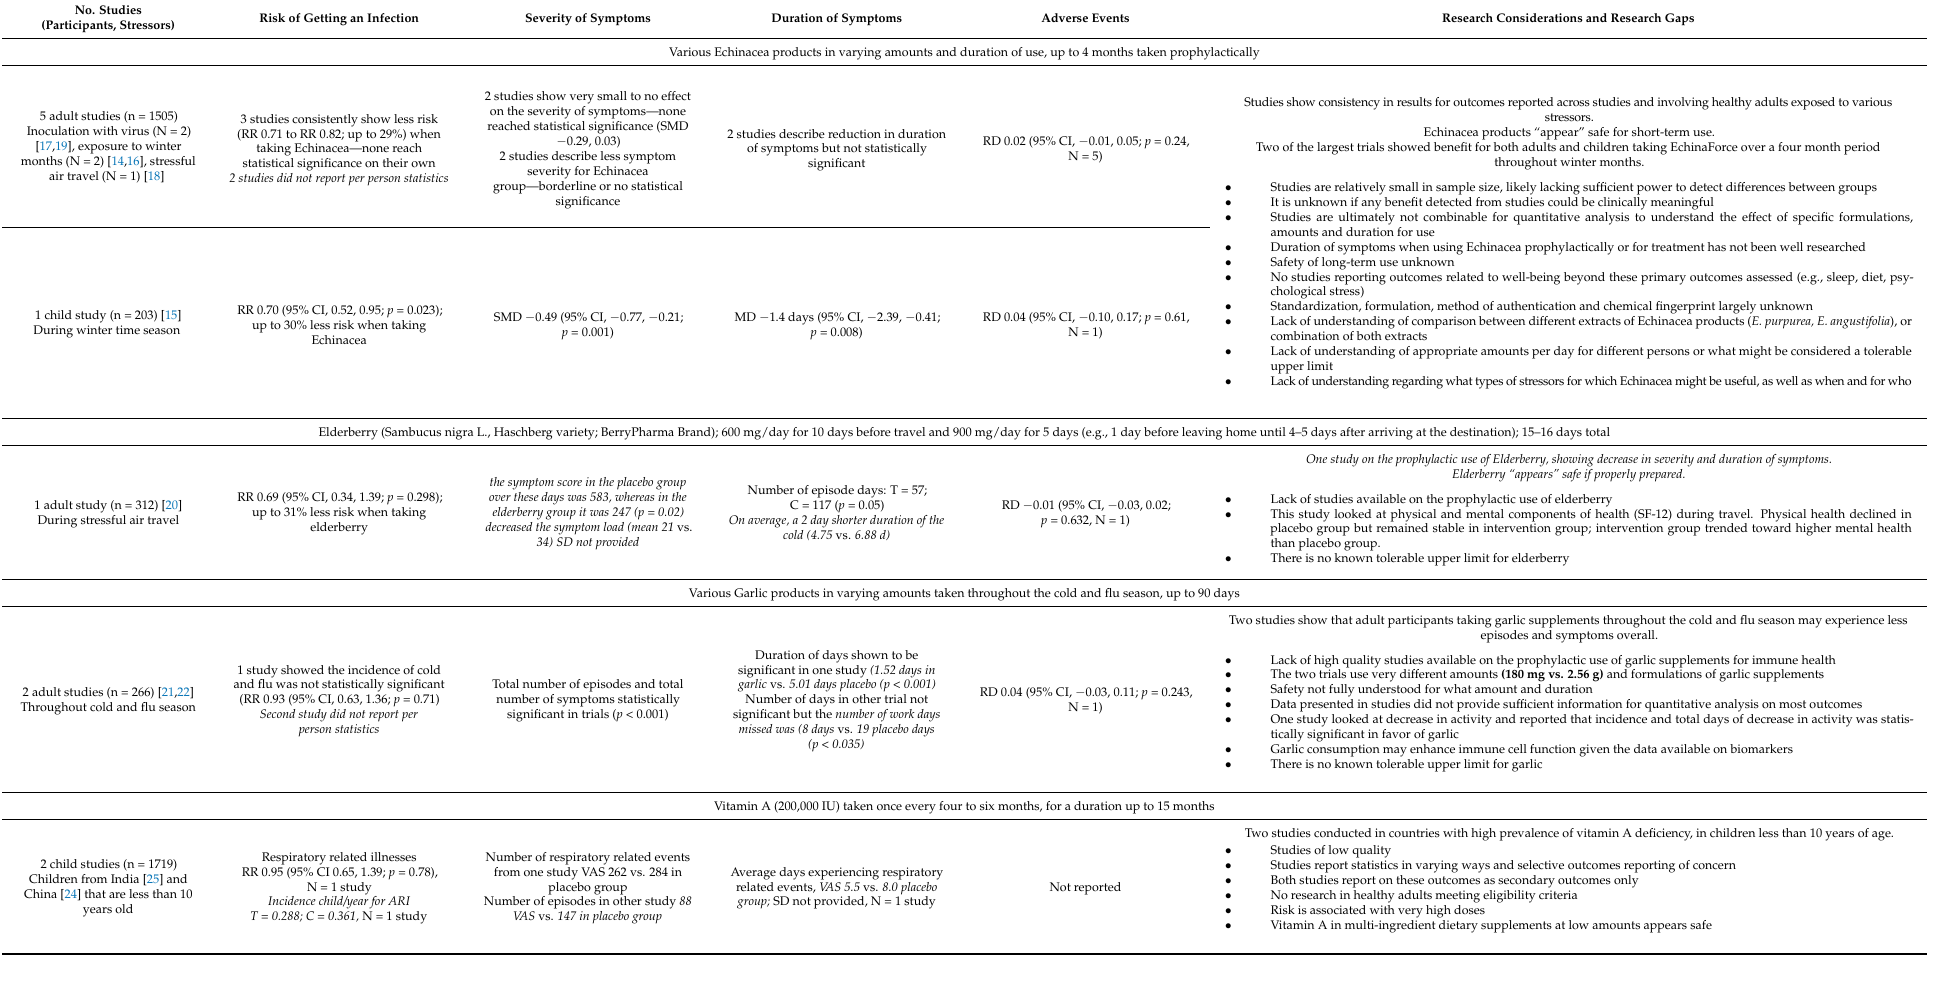
Table 2. Summary of the